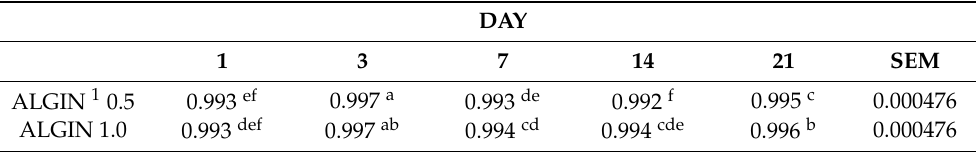
Table 9. Interactive effect of ALGIN × DAY on water activity (a w ) on pet food formulations during a simulated retail